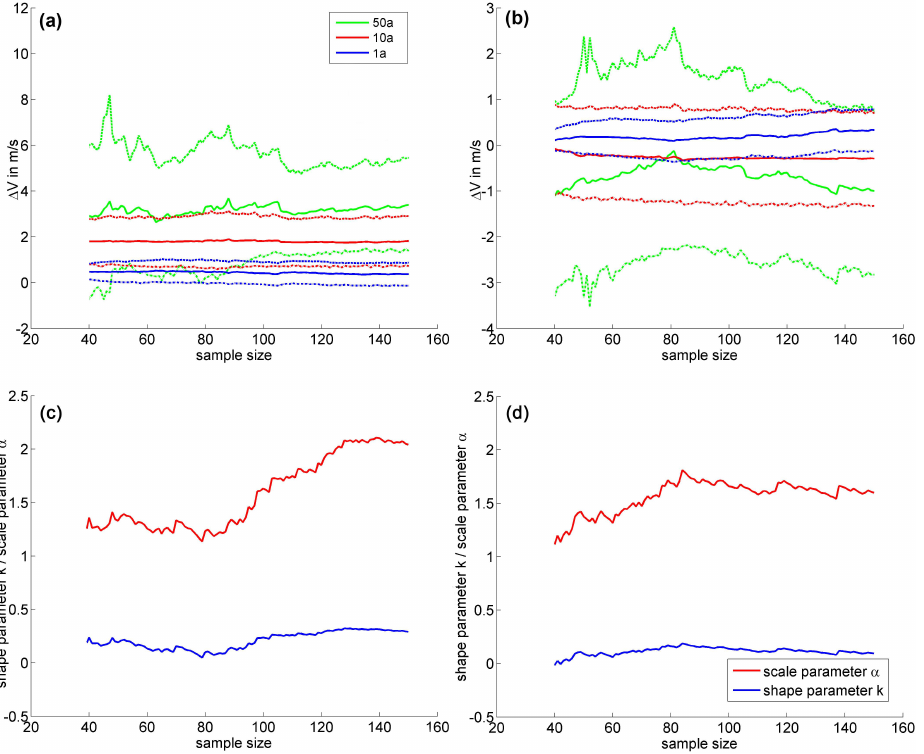
Fig. 4. Absolute changes in gust wind speed between A1B and CTRL with 90% confidence intervals (dotted lines) for a 1-, 10-, and 50-year RP ( a and b ) and parameter values, α and k , for a 10-year RP in CTRL ( c and d ) as a function of sample size at two different grid points of ECHAM5, at 51 ◦ N/9 ◦ E (a and c) and 49 ◦ N/9 ◦ E (b and